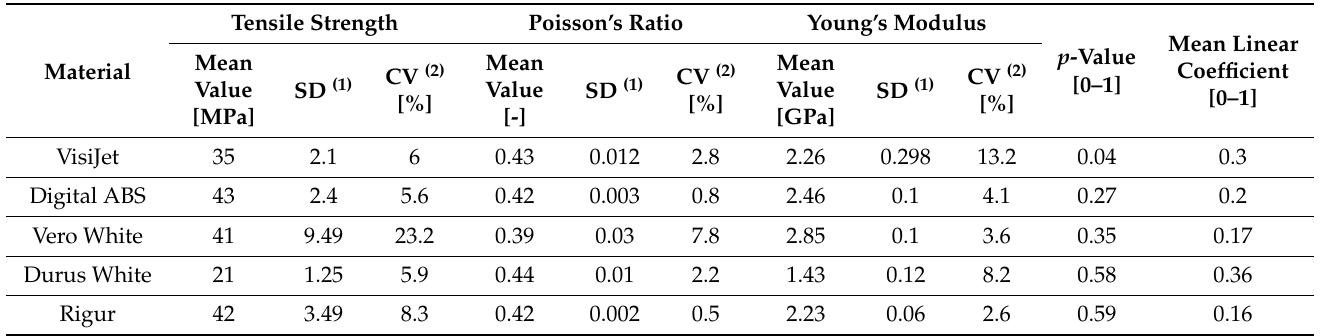
Table 2. Summary of mechanical properties of specimens for PJ and MJ